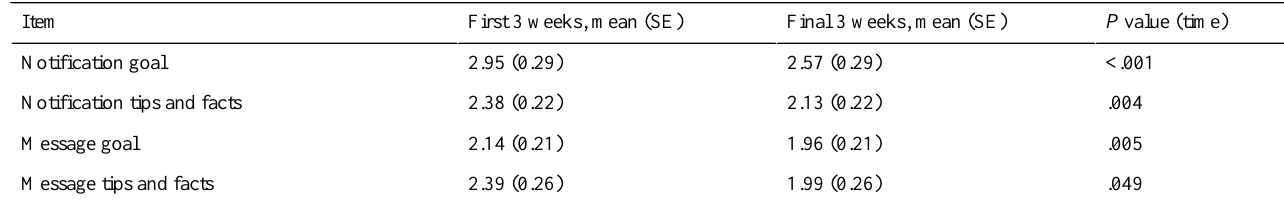
Table 5. Frequency of reading notifications and messages regarding goals, tips, and facts from the Active Coach app. 6-point scale: 1=never; 2=less than once a week; 3=once a week; 4=2-4 times a week; 5=every day; 6=multiple times a day.